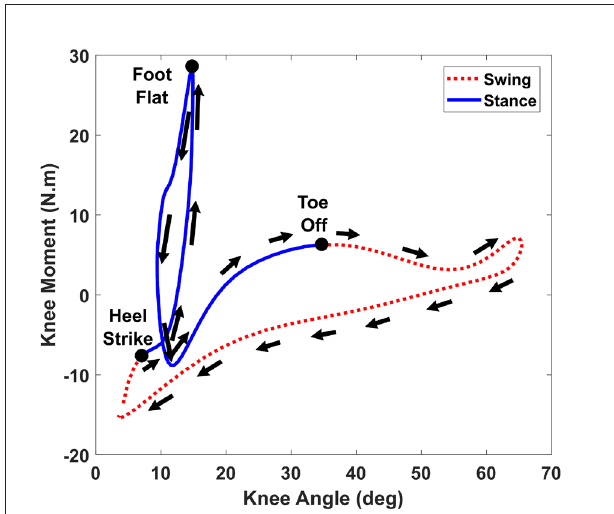
Figure 5 | Modeling of human knee stiffness during walking. The averaged knee stiffness for stance and swing phase are calculated individually using the slope of the curve at the respective